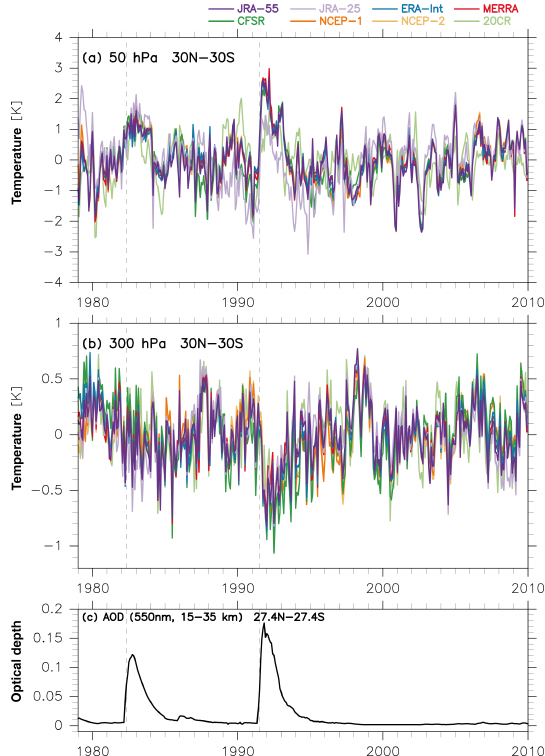
Figure 3. Time series of temperature residual R(t) (including vol- canic signals and random variations) averaged for 30 ◦ N–30 ◦ S for the 1979–2009 regression analysis from eight reanalysis data sets at (a) 50hPa and (b) 300hPa. (c) Time series of aerosol optical depth at 550nm averaged for 27.4 ◦ N–27.4 ◦ S and integrated for the re- gion 15–35km. Vertical dotted lines indicate the starting date of the two volcanic